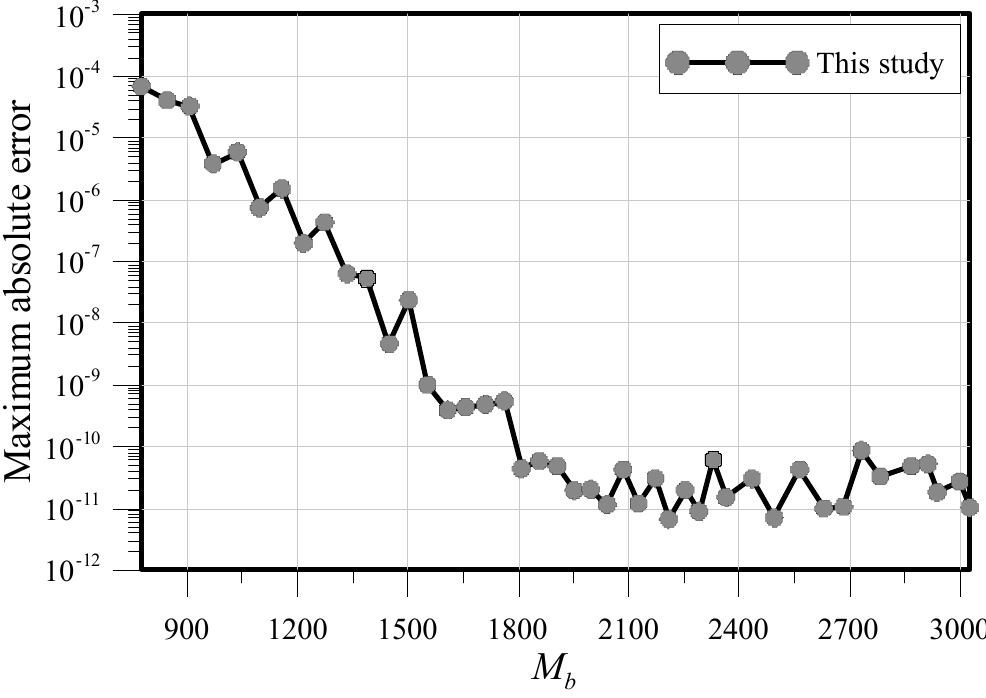
Figure 17. The number of boundary points versus the maximum absolute error.